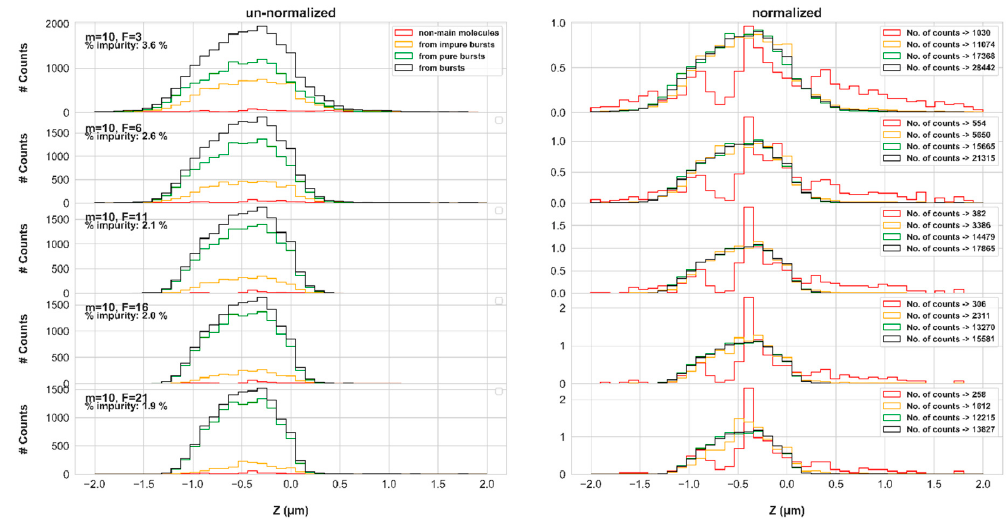
Figure 7. The molecular positions of pure and impure bursts photons, as a function of varying instantaneous photon rate threshold values, F (numerical PSF model)—shape and amplitude. We the histograms of molecular positions in the z coordinate of impure photons (red), burst photons of impure bursts (yellow), of pure bursts (green), and of all bursts (black), both un-normalized (left) to assess the weight of burst impurity, and normalized (right) to assess the histogram shapes. These results refer to the simulations in concentration of 62 pM and diffusion coefficient of 90 μ m 2 /s, using the numerical PSF model.